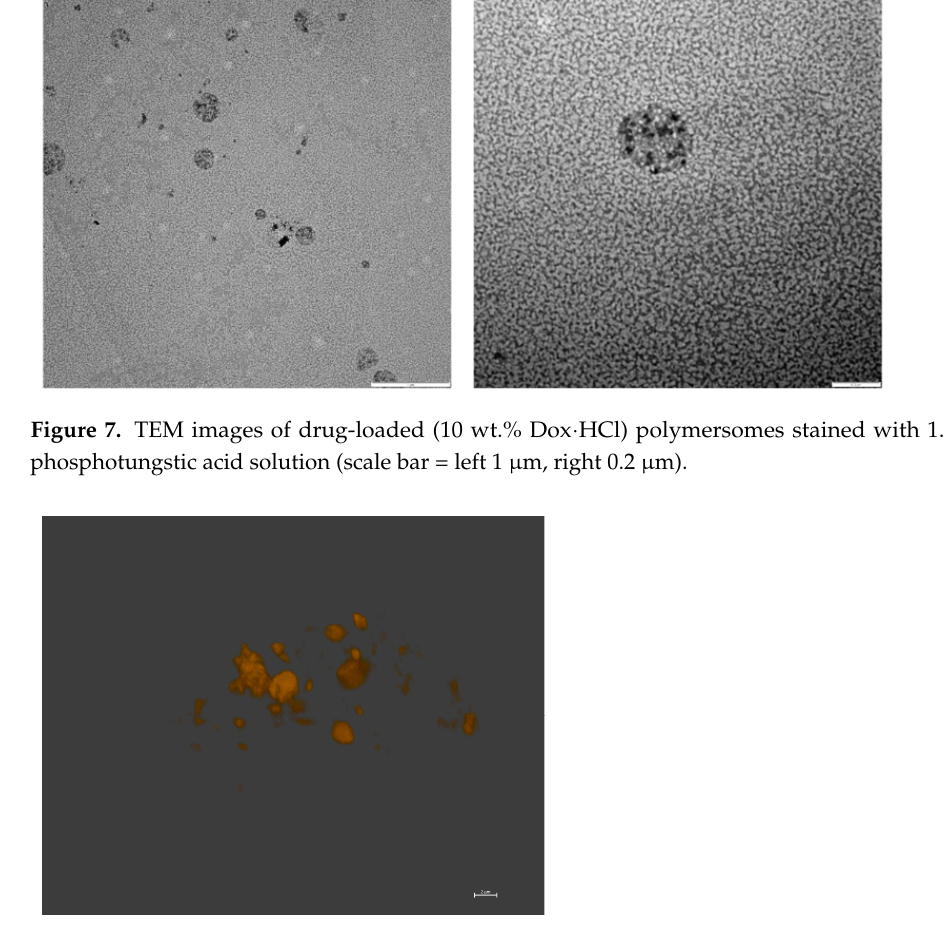
Figure 8. CLSM image of drug-loaded (10 wt.% Dox·HCl) polymersomes (scale bar = 2 µm).